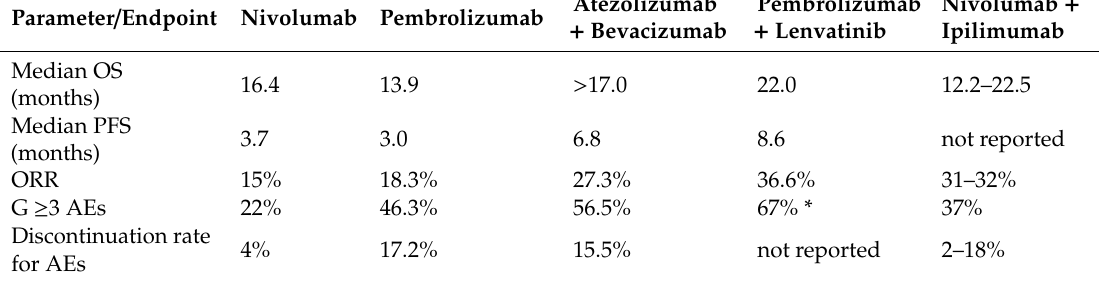
Table 6. Comparison of the main e ffi cacy and safety data from clinical trials of immune checkpoint inhibitors in monotherapy or in combination with other